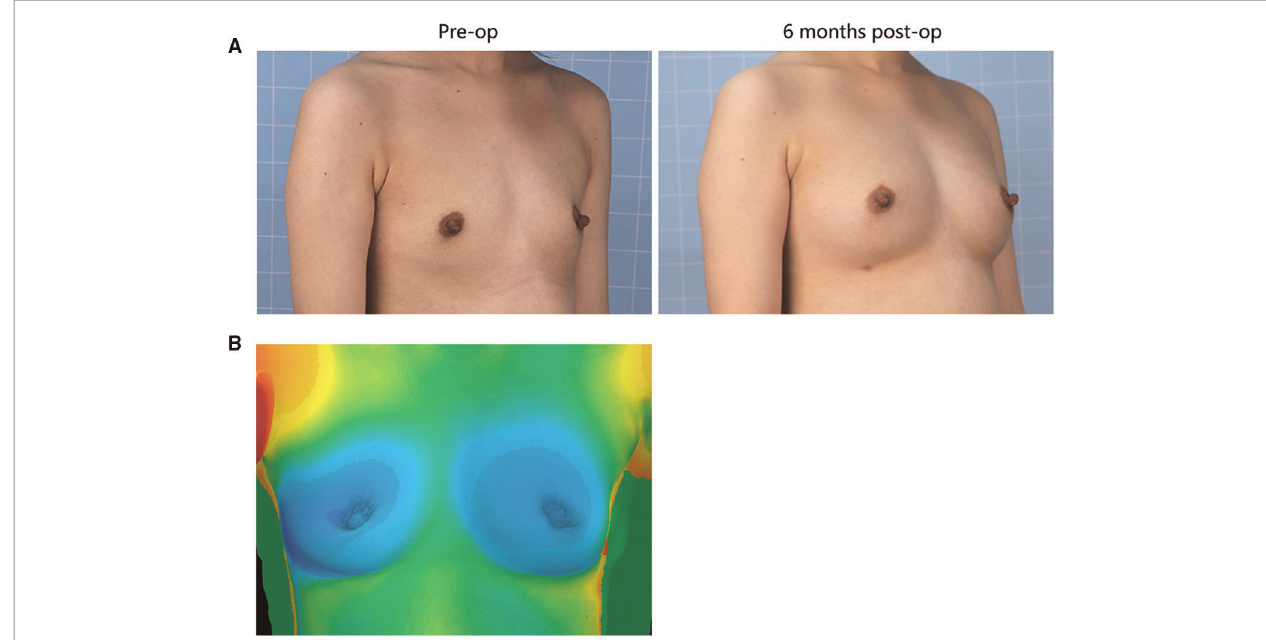
FIGURE 2 | ( A ) 25-year-old female patient from the retropectoral group presented with involutional atrophy of the breasts. She received 300 mL lipoaspirates per breast, with 200 mL into the retropectoral space, 50 mL into the subcutaneous plane and 50 mL into the retromammary space. Six months after surgery, the breasts gained fullness and a well-de fi ned shape. ( B ) The 3D laser scanner demonstrated the volume change before and after surgery.